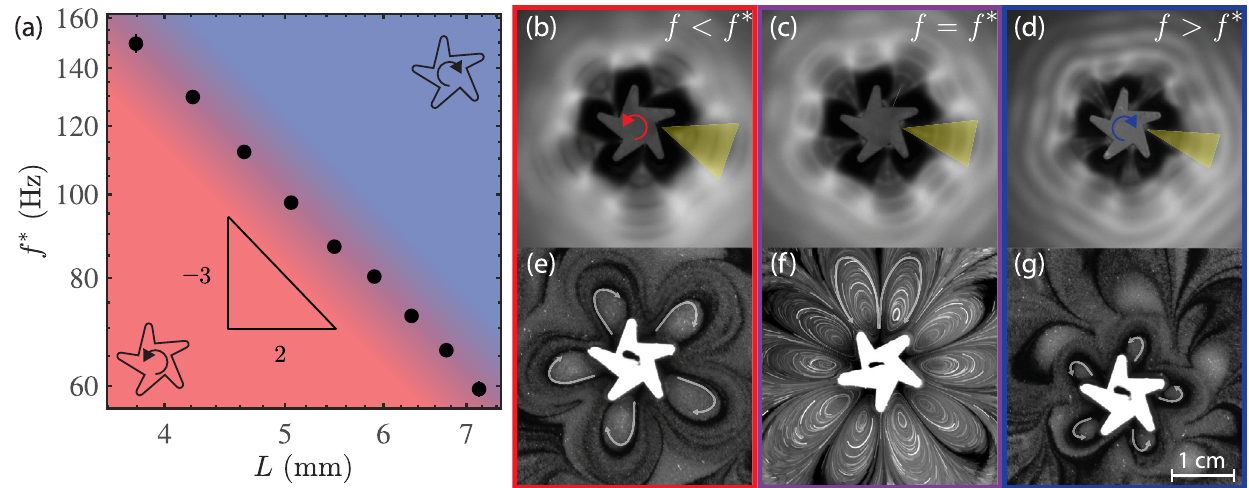
Fig. 2 Bidirectional rotation and the fl ipping frequency. a Plot of the fl ipping frequency f * at which Ω = 0 for nine different spinner sizes in the range L = 3.8 − 7.2 mm. For f < f * the spinner rotates counter-clockwise (red region) and clockwise for for f > f * (blue region). b – d We use a shadowgraph imaging technique to visualize the wave- fi eld generated by the oscillating spinner and in e – g distributing tracer particles at the interface reveals qualitatively similar characteristic streaming- fl ow patterns for a typical spinner of size L = 6.3 mm across the range of frequencies considered in experiments. In b – d , constructive interference of waves propagating from each arm of the spinner gives rise to rays (indicated by yellow triangles) centered at the vertex of each of the fi ve wedges. As the frequency increases, the bands of constructive interference narrow and the fl ow structure changes from having e a single bound vortex attached to the long arm of the spinner when f < f * to f two closed vortices in each wedge when f = f * and then fi nally to g a single bound vortex attached to the short arm of the spinner for f > f * . See Supplementary Movies 1 – 4 for real-time movies of the bidirectional rotation. The error bars in a represent one standard deviation in the fl ipping frequency over six trials, and in some cases are smaller than the marker size process can be found in the Methods section. As depicted in Fig. 1b, chirality is induced by fi ve wedges separating the points of the star, parameterized by a wedge opening angle of θ w = 94.4 π / 180 and short- and long-arm lengths of ℓ s and ℓ l , respectively, with ℓ l / ℓ s = 1.7. Geometric similarity thus allows the spinners to be characterized by a single length scale, chosen here to be the wedge opening length L . The hydrophobic chiral stars are then placed on the surface of a liquid bath consisting of a water- glycerol mixture, which in turn is mounted on an in-house electromagnetic shaker 33 (Fig. 1c) vibrating vertically with acceleration Γ ð t Þ ¼ γ cos 2 π ft , where γ is the maximum vertical acceleration, f is the vibration frequency, and t is time. All experiments reported herein were conducted below the Faraday threshold of the fl uid, and hence the free surface remains fl at in the absence of the spinners.